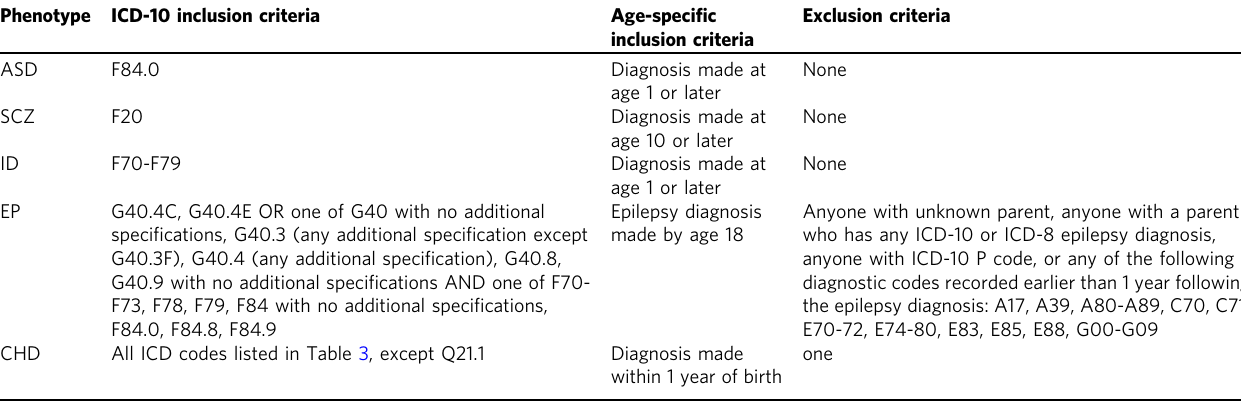
Table 2 Speci fi c inclusion and exclusion criteria for queries of the Danish registries Phenotype ICD-10 inclusion criteria